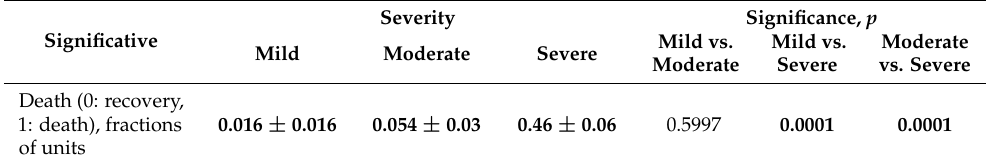
Table 6. The outcome of the disease depending on the severity of the COVID-19